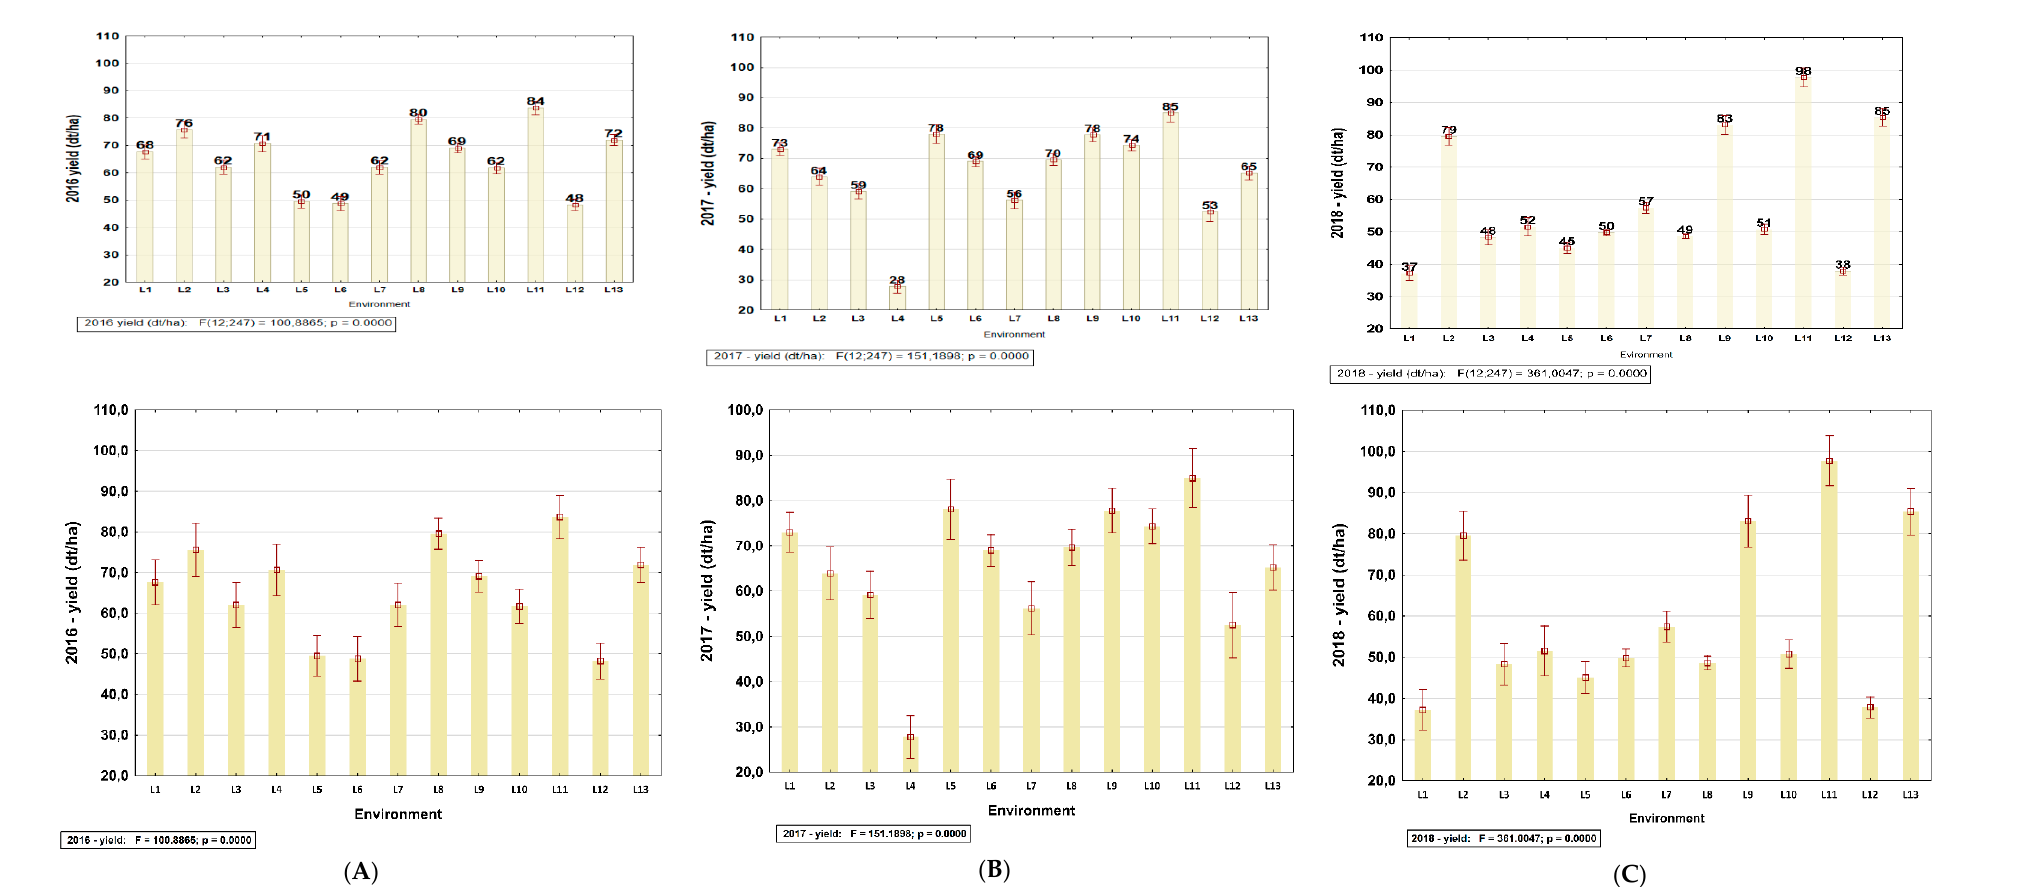
Figure 2. Average barley grain yields in dt/ha harvested from 20 varieties growing at randomized experiments at thirteen environments (L1–L13) in 2016, 2017, and 2018 years. ( A ) represents average grain yields harvested from 20 varieties in thirteen environments (L1–L13) in 2016 year. ( B ) represents average grain yields in dt/ha harvested from 20 varieties in thirteen environments (L1–L13) in 2017 year. ( C ) represents average grain yields in dt/ha harvested from 20 varieties in thirteen environments (L1–L13) in 2018 year. Analysis of variance (ANOVA test; α ≤ 0.05) values, which are presented under the figures, confirm the significant differences for grain yield harvested from 20 varieties between environments in 2016 ( A ), 2017 ( B ), and 2018 ( C ). The bars represent mean value and standard deviation (SD) for each environment.